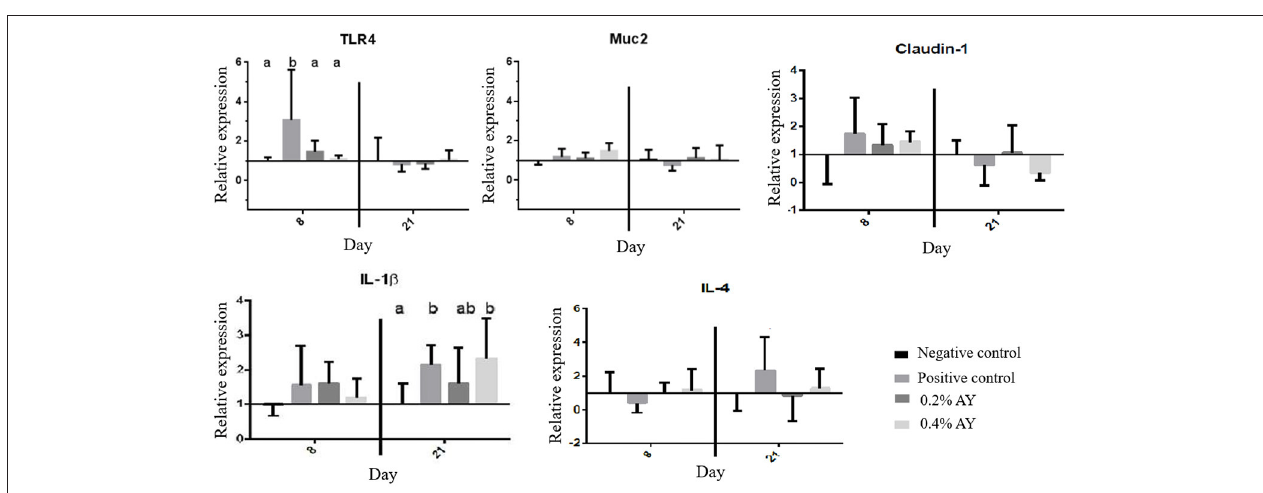
FIGURE 1 | Relative gene expression of TLR-4, MUC2, Claudin-1, IL-1 β , and IL-4 in the ileum of broiler chickens supplemented with zinc bacitracin or autolyzed yeast of Saccharomyces cerevisiae . Values are means ± SEM (1 bird/pen; 7 birds/treatment). ab Means with different superscripts in a column differ significantly ( P ≤